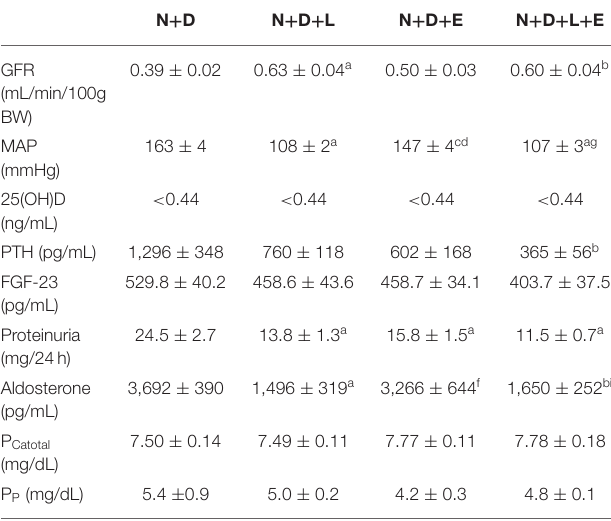
TABLE 1 | Renal function, hemodynamic and biochemical parameters evaluated 60 days after 5/6 nephrectomy (N) in vitamin D deficient rats (D) treated with losartan (L), erlotinib (E) or losartan + erlotinib (L +